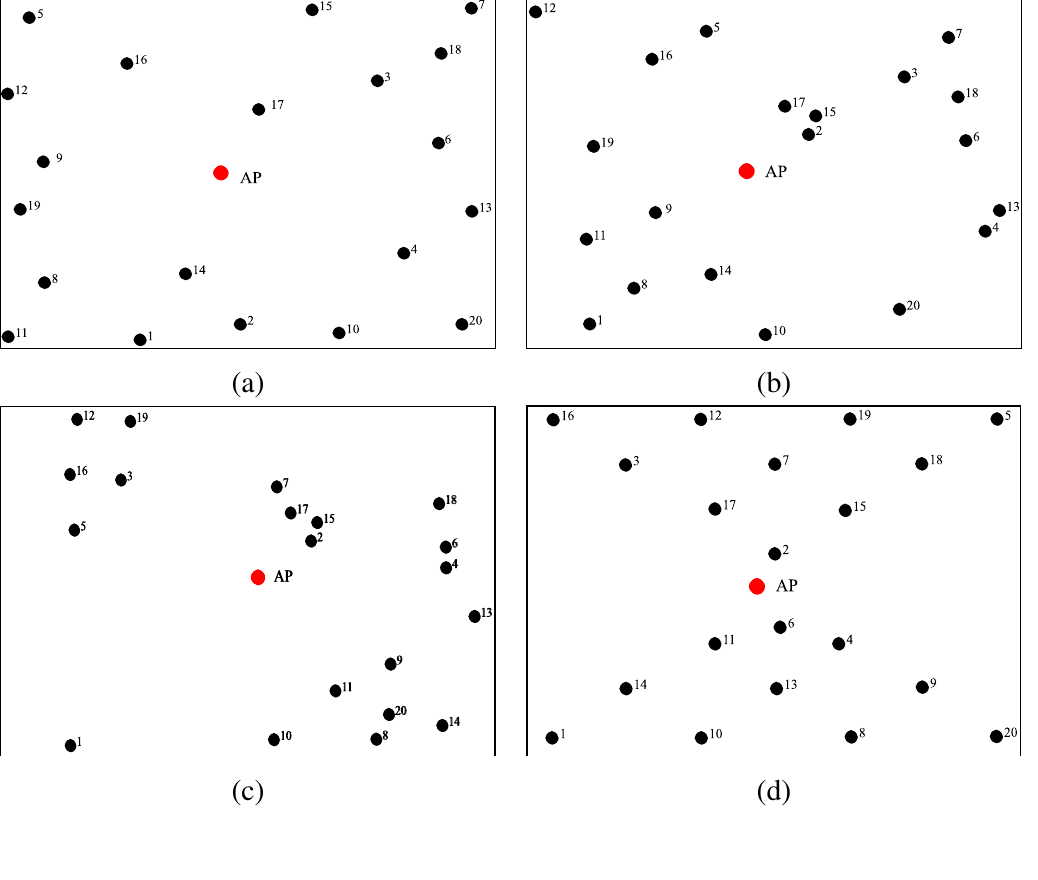
Figure 3. Considered network topologies with N = 20 nodes.